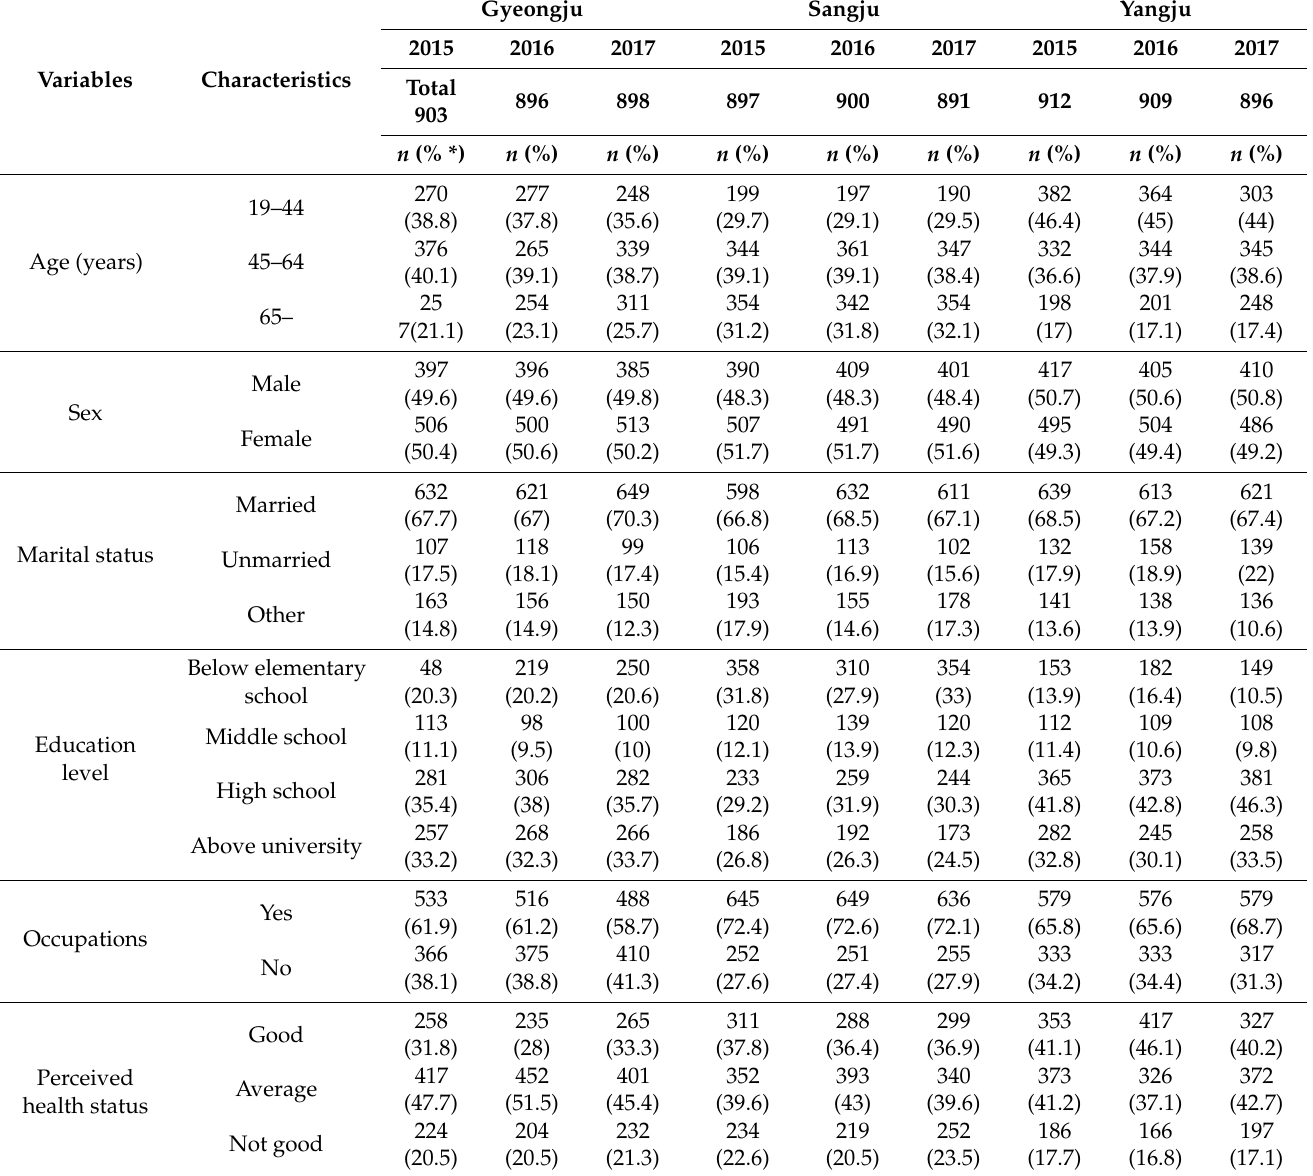
Table 1. Demographic characteristics of the participants ( n =